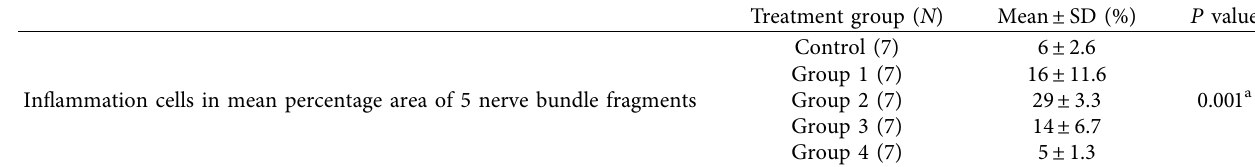
Figure 1: Summary of the sample treatment. (a) Identifying sciatic nerve. (b) Marking and treating nerve lesion using surgical thread. (c) Blood extraction process. (d) Administering PRP immediately after nerve injury (group 1). (e) Administering PRP on day 3 after nerve injury (group 2). (f) Storing process of sample slides after sacrifice; sample slides are wrapped, coded, and stored in formalin. Table 1: Inflammation cells found on histopathologic analysis on each treatment groups.